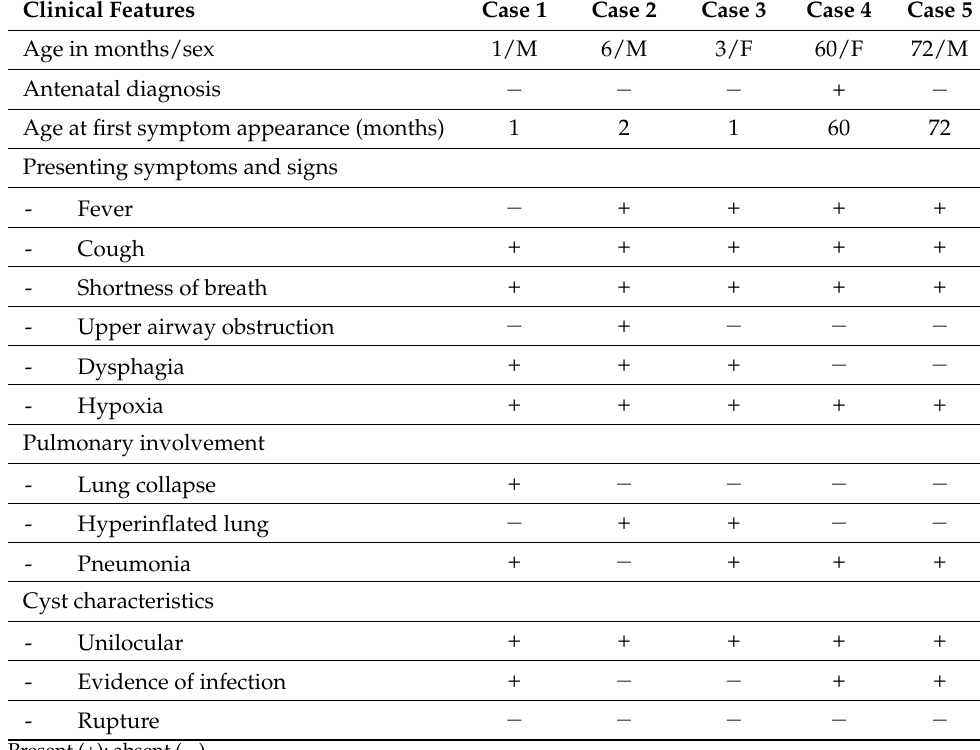
Table 1. Clinical characteristics of the patients.